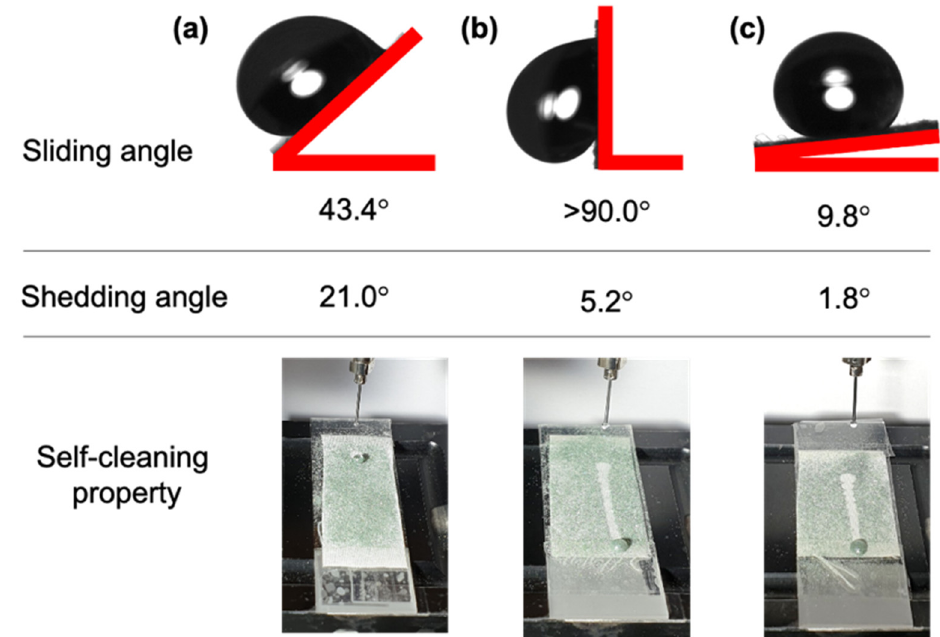
Figure 5. Sliding angles, shedding angles, and self-cleaning property of the untreated PP fabric (UT) ( a ) and superhydrophobic specimen treated with plasma etching for 15 min and thermal aging at 120 °C for 1 h (E15H120 1 h) ( b ), and plasma etching for 15 min and thermal aging at 120 °C for 24 h (E15H120 24 h) ( c ).